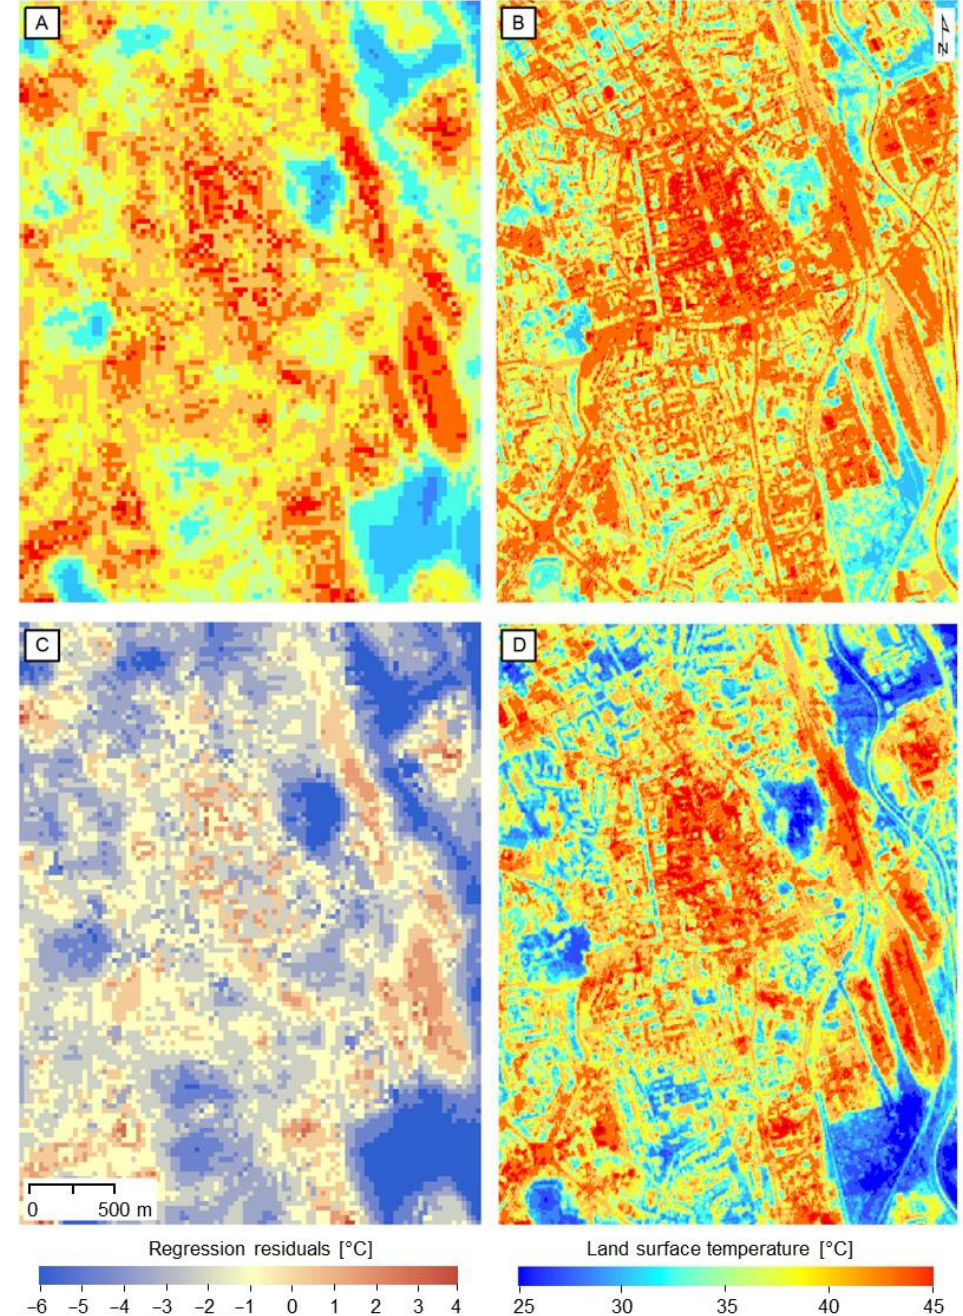
Figure 7. LST derived for the study area in Figure 1 ( A ) from Landsat 8 TIRS data at 30 m resolution; ( B ) as downscaled LST at 10 m resolution; ( C ) shows regression residuals derived from Equation (4) at 30 m grid; ( D ) downscaled LST at 10 m resolution with residuals; ( C ) convolved to 10 m grid and added back to ( B ).